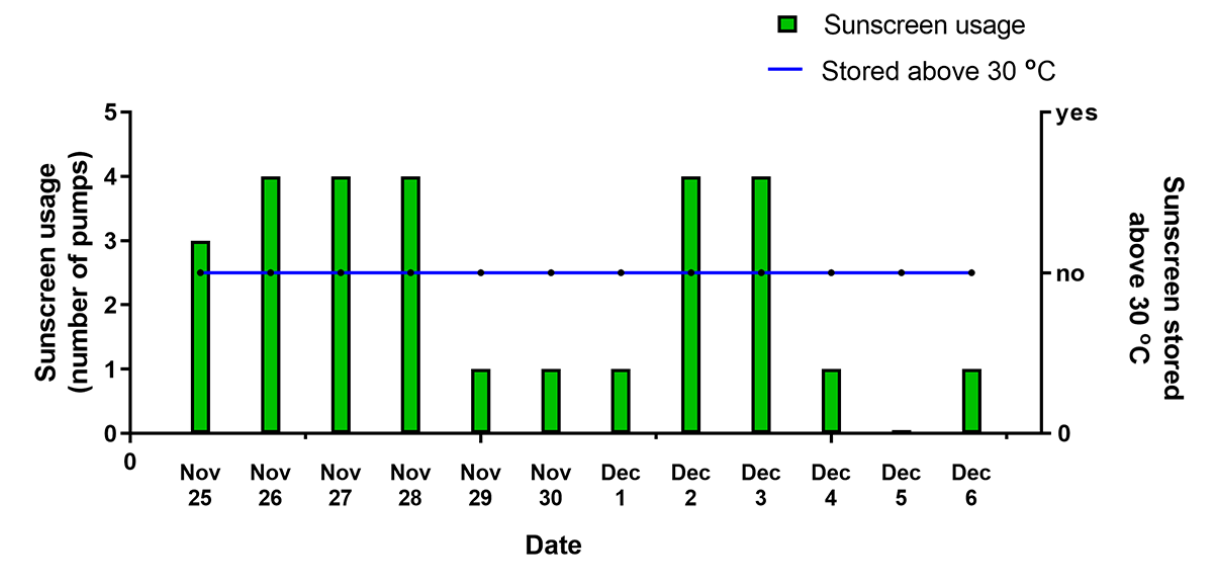
Figure 5. Data received each day from the smart sunscreen station, including number of pumps and temperature